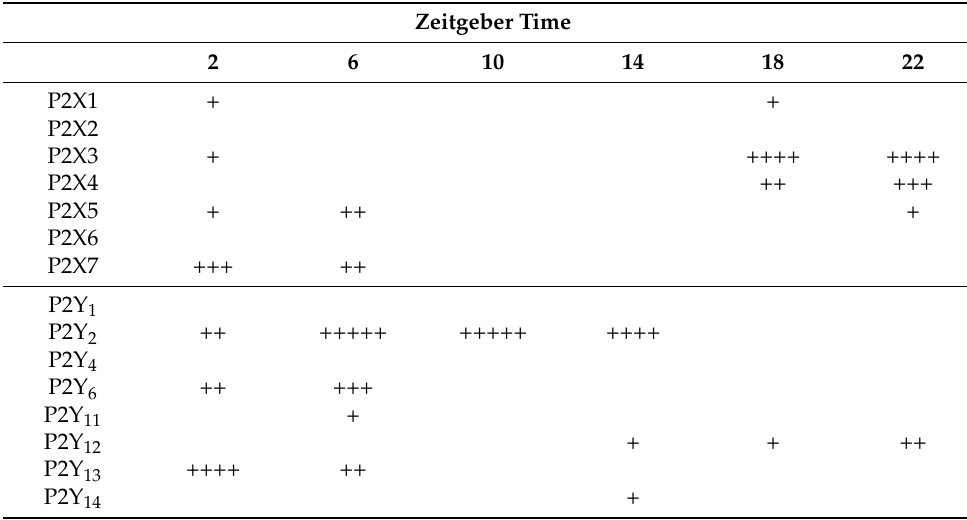
Table 3. Temporal distribution of P2 receptor expression in the hippocampal